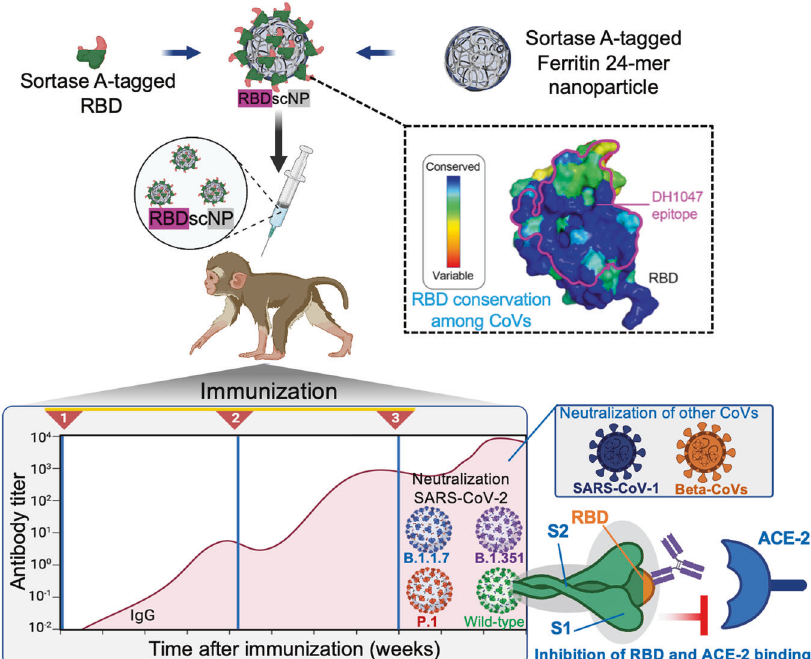
Fig. 1 Schematic representation of the key steps followed to develop and evaluate the SARS-scNP vaccine. The RBD-scNP vaccine elicits extremely high titers of neutralizing antibodies (IgG) against SARS-CoV-2 virus, its emerging variants and other related beta-CoVs including BatCoV-WIV-1, and BatCoV-SHC014. RBD harbors conserved epitopes, including the DH1047 epitope within beta-CoV spikes. Receptor binding domain (RBD); angiotensin-converting enzyme-2 (ACE-2); RBD-sortase A conjugated nanoparticle (RBD-scNP); immunoglobulin G (IgG); severe acute respiratory syndrome coronavirus-2 (SARS-CoV-2); coronaviruses